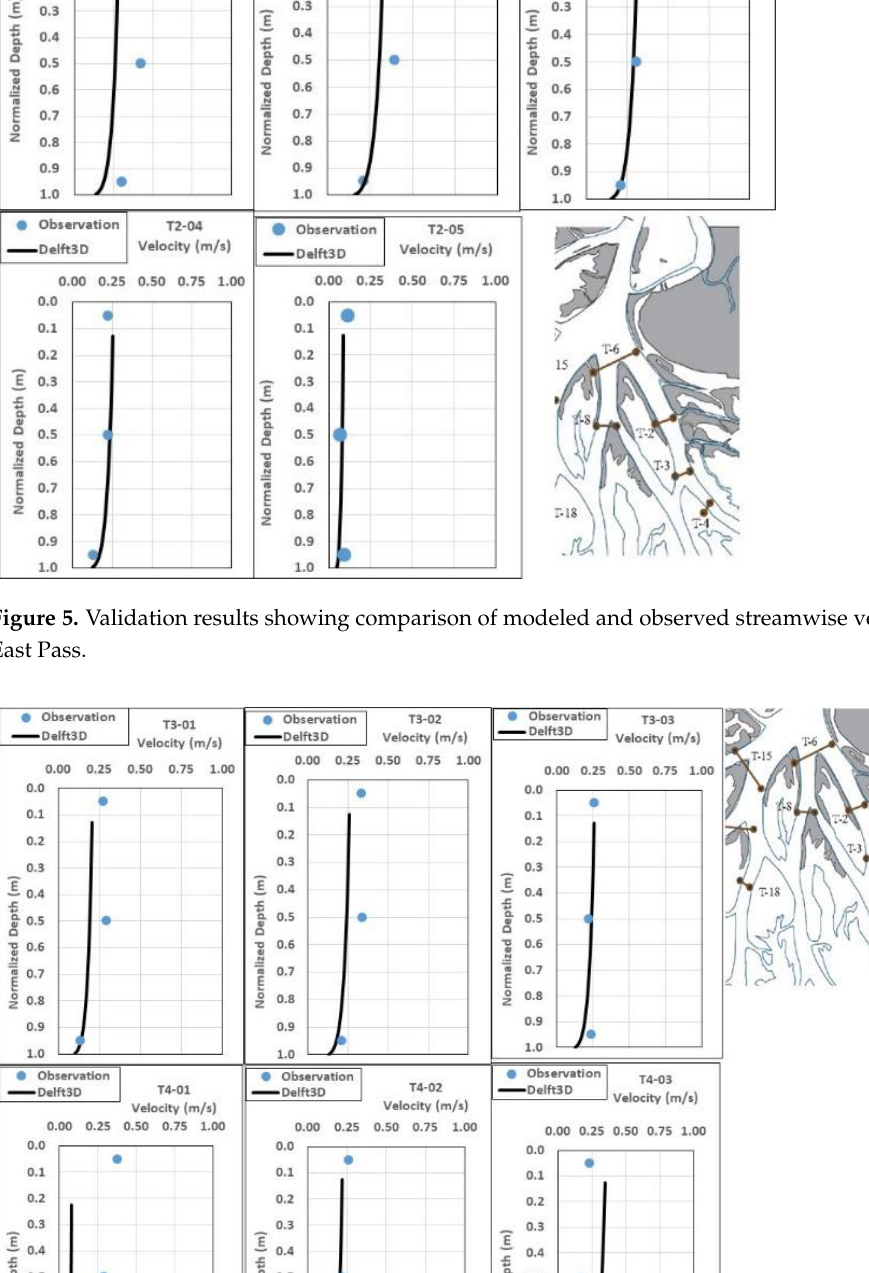
Figure 6. Validation results showing comparison of modeled and observed streamwise velocities at East Pass (further downstream).